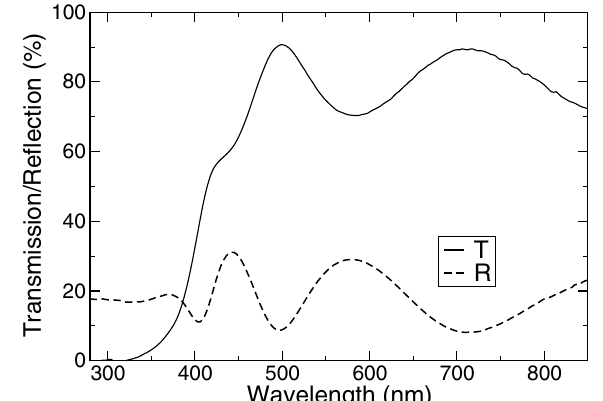
Fig. 4. Optical transmission ( T ) and reflection ( R ) of a Zn(O,S) film (thickness 400 nm) sputtered from a mixed tar- get without substrate heating onto a soda lime float glass